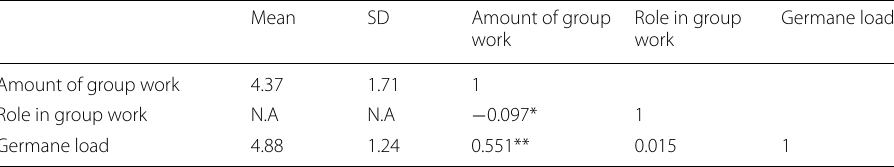
* Correlation is significant at the 0.05 level ** Correlation is significant at the 0.01 level